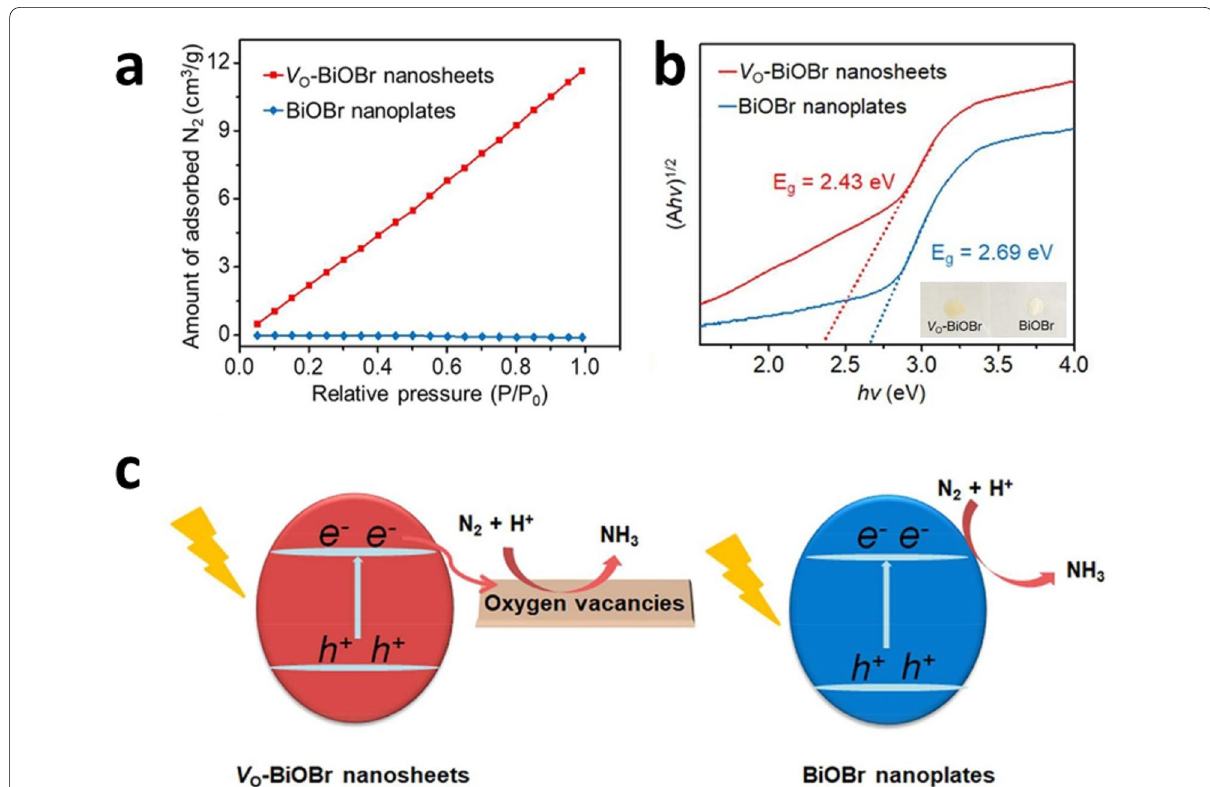
Fig. 4 a The N 2 adsorption isotherms, b The Tauc plot ( ahv ) 2 versus ( hv ) and c The schematic illustration of pohtocatalytic NH 3 synthesis process on Vo-BiOBr nanosheets and BiOBr nanoplates, respectively. Reproduced with permission [49]. Copyright 2018, American Chemical